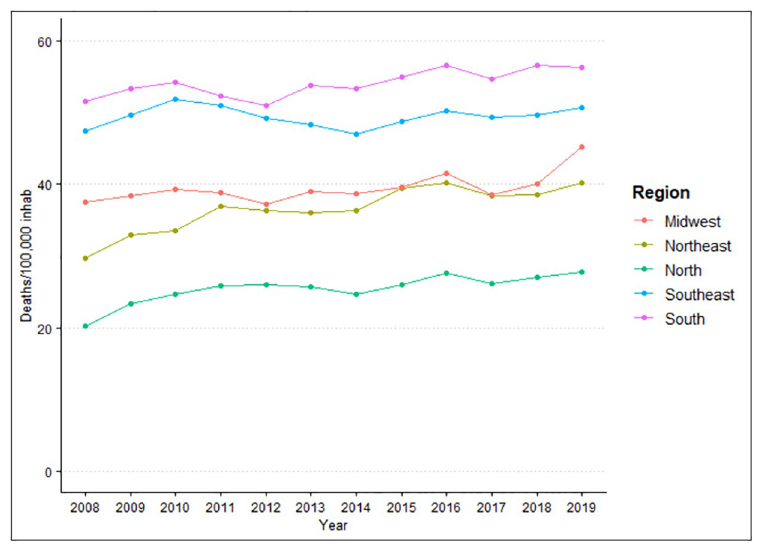
Fig 5. Number of deaths caused by cardiovascular diseases per 100 thousand inhabitants according to the region of residence in the period from 2008 to 2019. Source: Brazilian Institute of Geography and Statistics (IBGE) and Ministry of Health–Hospital Information System of the Unified Health System (SIH/SUS)